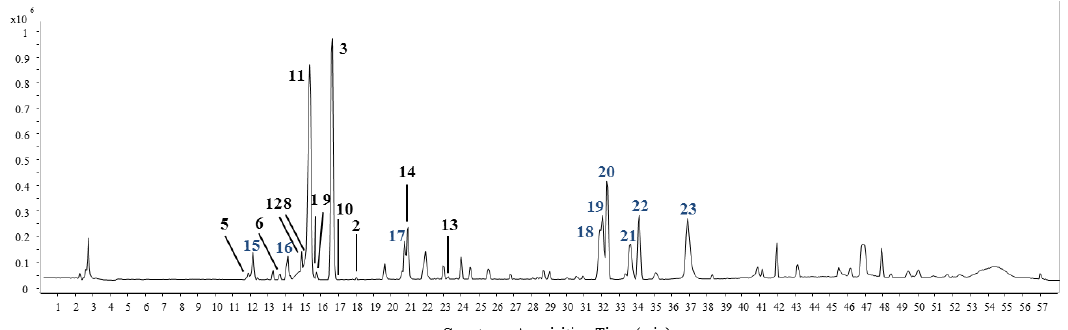
Figure 3. Total ion chromatogram of HJF by HPLC-ESI-qTOF-MS / MS in the negative ion mode. Peak assignments with isolated ( 1 – 14 ) and predicted ( 15 – 23 ) compounds.